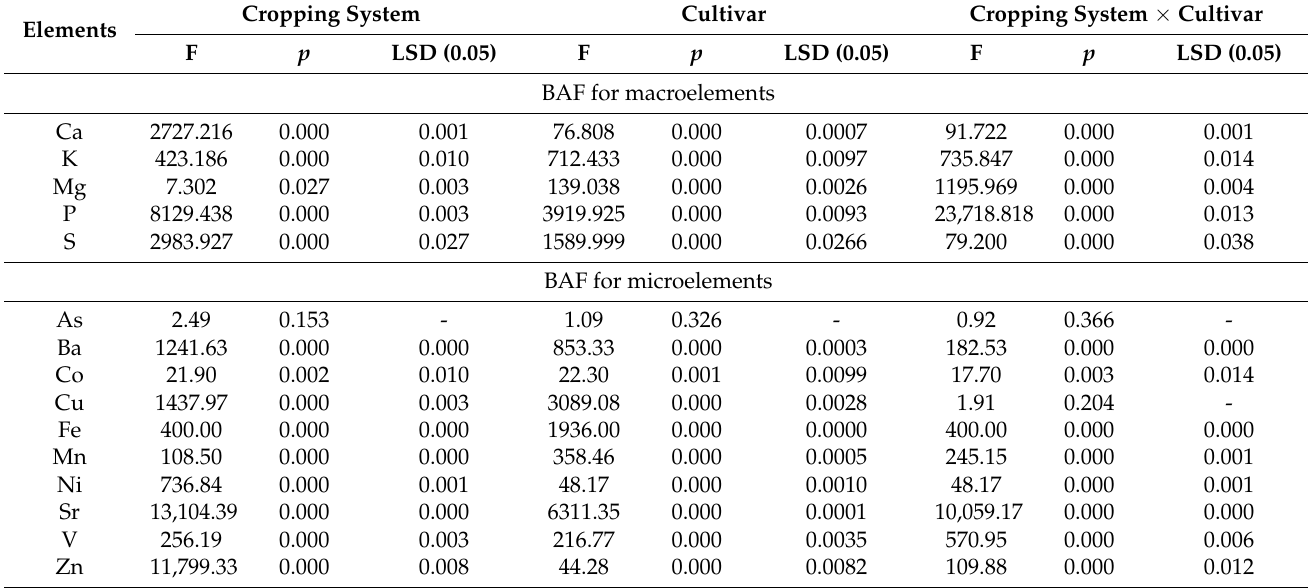
Table 5. Analysis of variance of the bioaccumulation factor of the macro- and microelements in ICS and CCS cropping